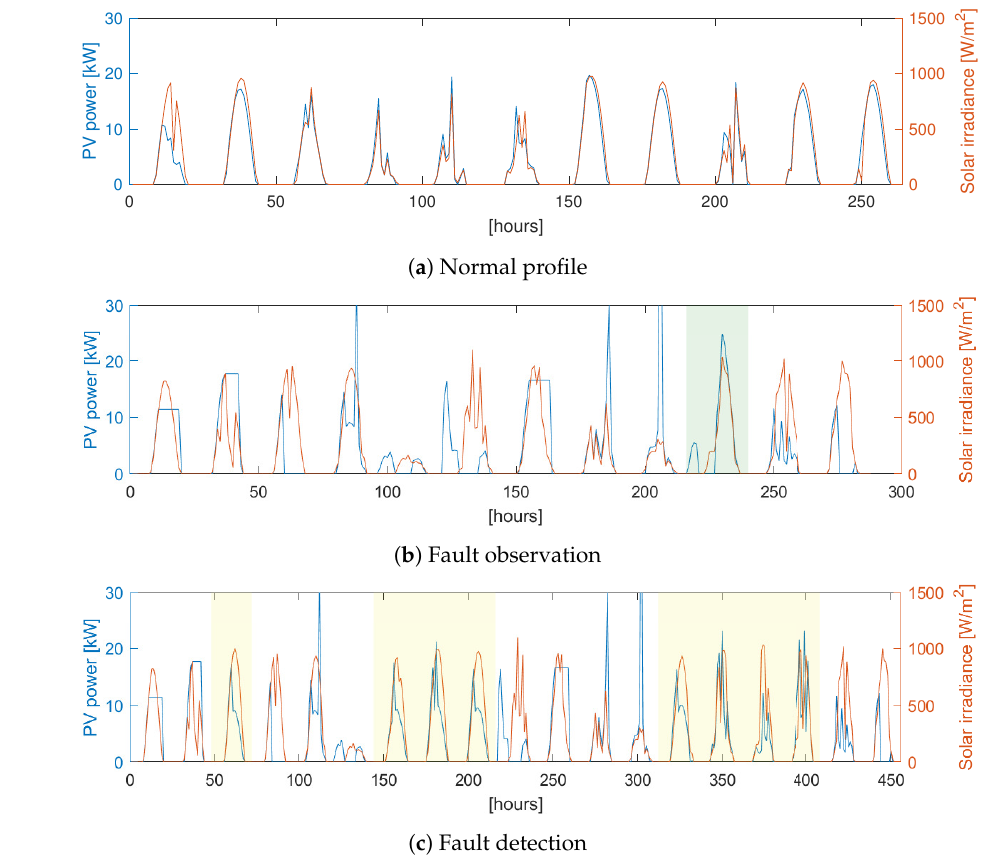
Figure 5. Profiles of PV power and solar irradiance for ( a ) normal, ( b ) fault injected, and ( c ) fault detected days.The green-shaded profile in ( b ) denotes a missing fault and the yellow-shaded profiles in ( c ) correspond to false alarms occurring at site